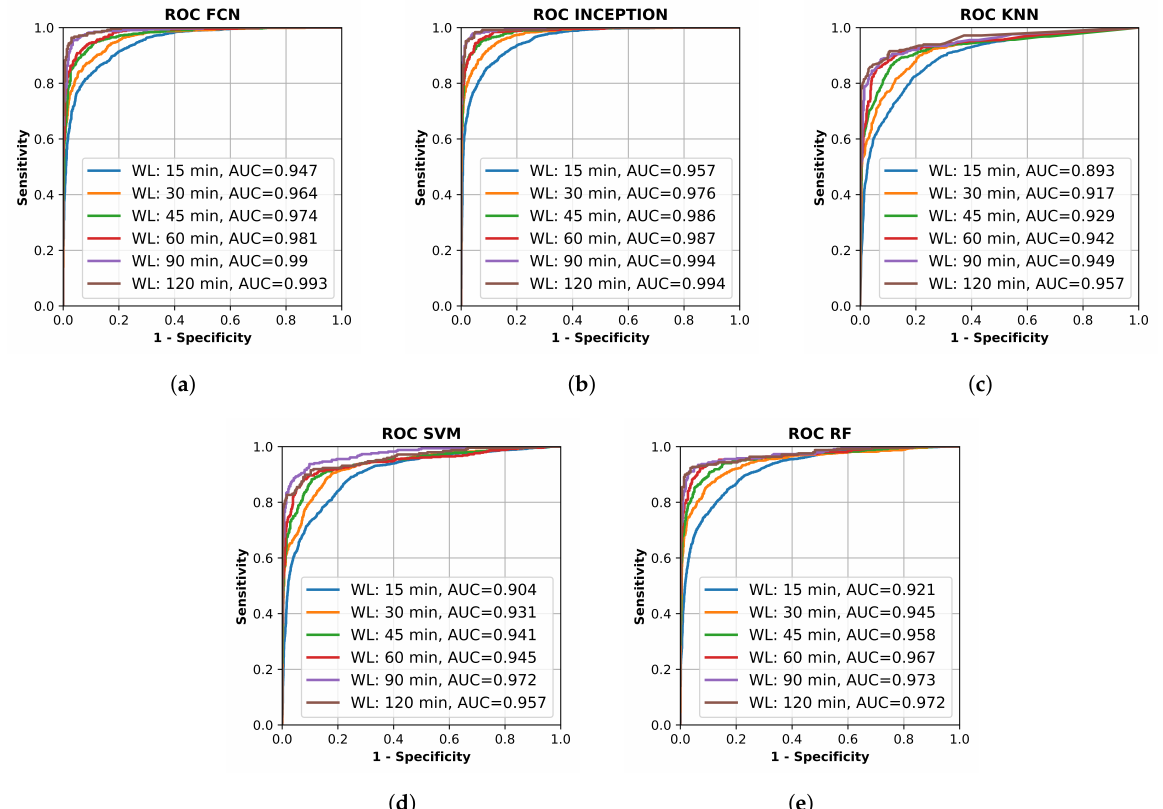
Figure 2. Receiver operating characteristic (ROC) curve for different trained machine learning models using different window lengths. ( a ) shows the deep learning classifier fully convolutional network (FCN); ( b ) shows the deep learning classifier InceptionTime (INCEPTION); ( c ) shows the K-nearest neighbors (KNN) classifier; ( d ) shows the support vector machine (SVM) classifier; and ( e ) shows the random forest (RF) classifier. Plots created using Matplotlib